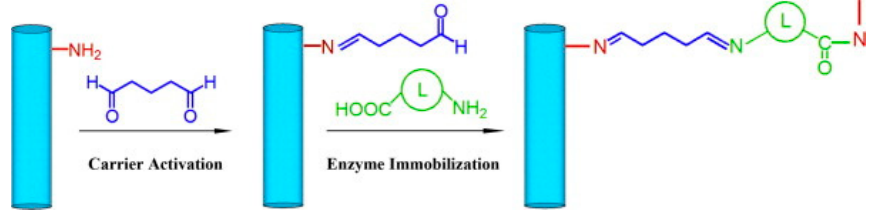
Figure 12. Illustration of carrier activation and enzyme immobilization using glutaraldehyde [137]. Reprinted with permission from Science Direct.